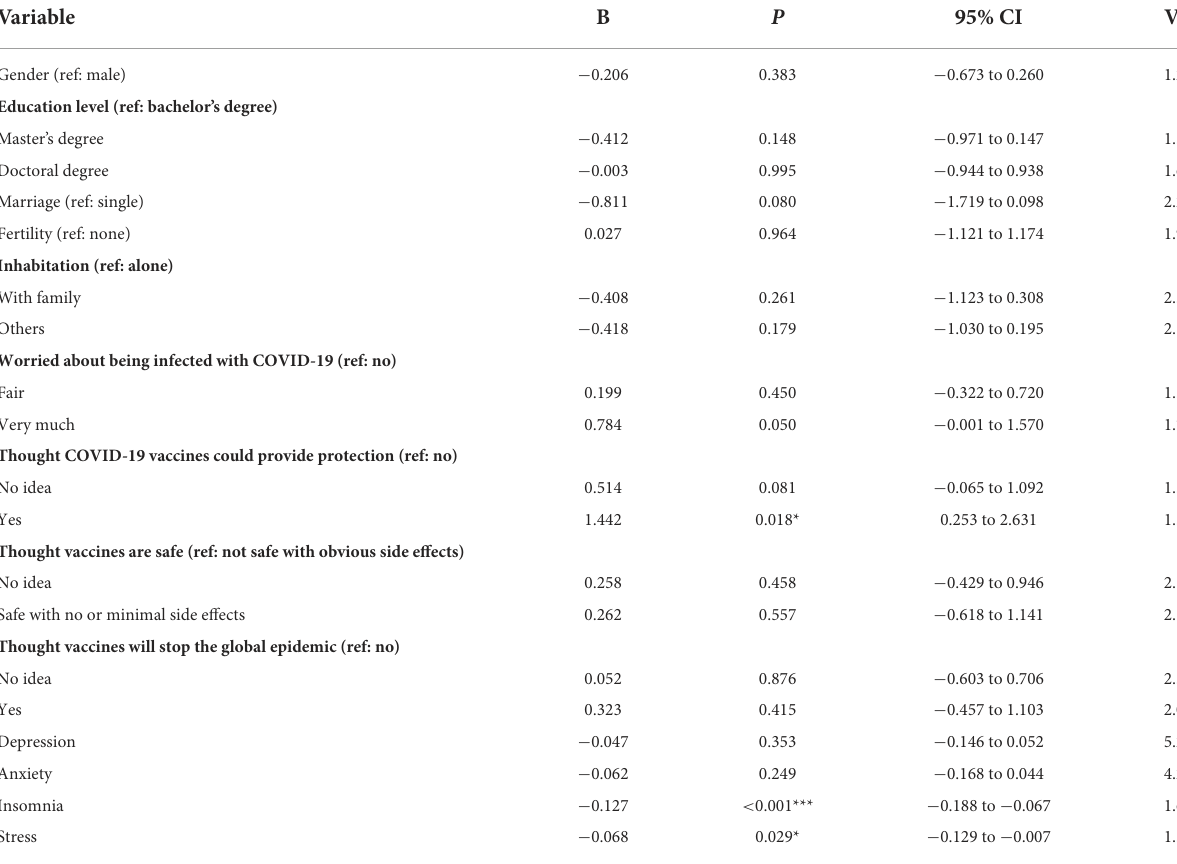
TABLE 3 Multiple linear regression analysis of quality-of-life related